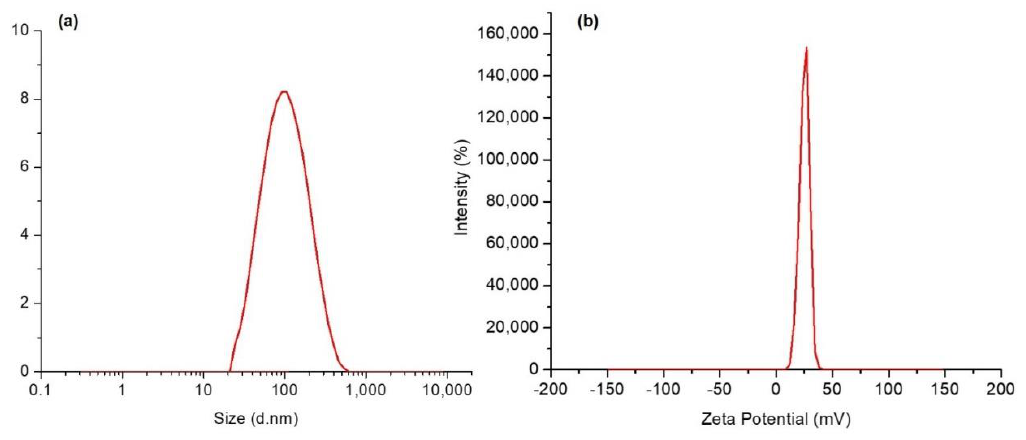
Figure 1. The particle size ( a ) and zeta potential ( b ) distributions of the LZ – CSNPs.